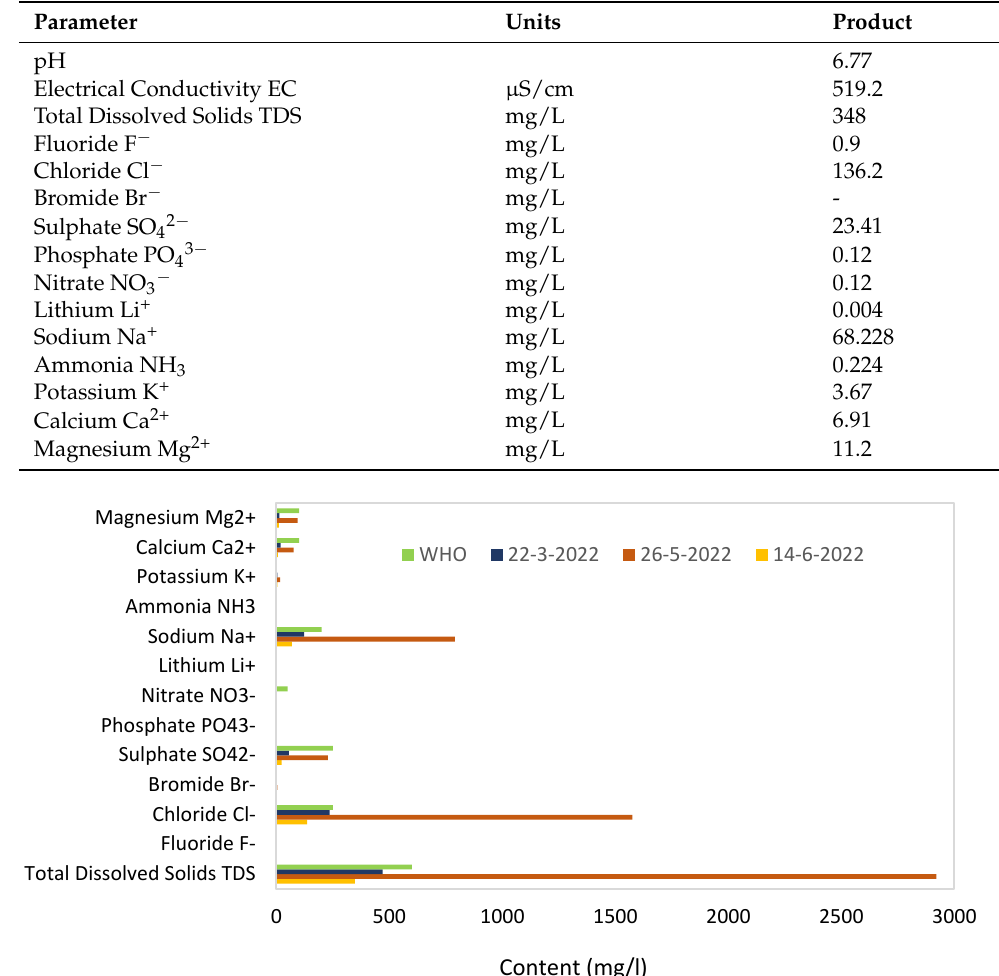
Table 4. Sample 3 (14 June 2022) Water Analysis (Prototype #2).